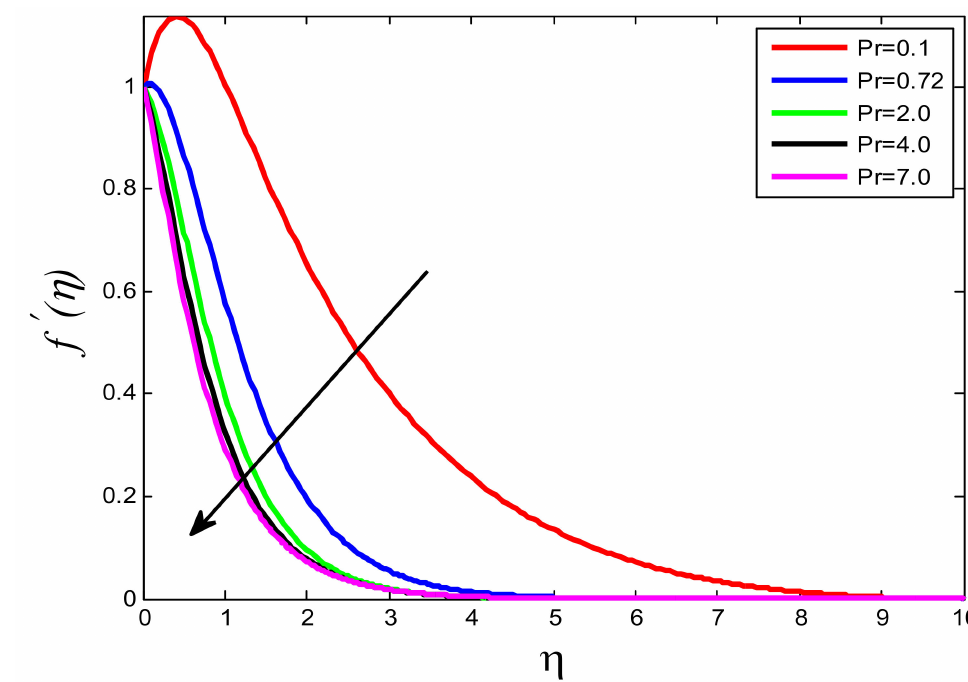
Figure 13. Influence of Pr on f (cid:48) ( η )